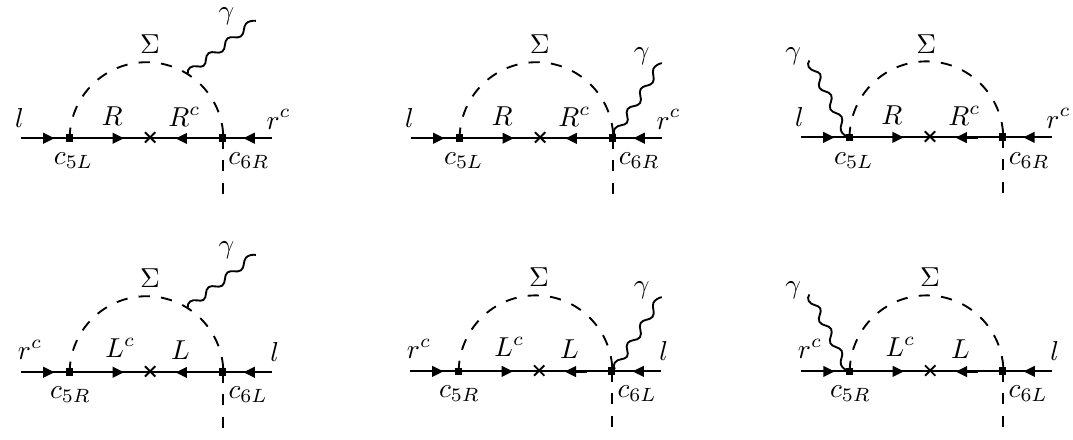
extended × SU(2) L R LR